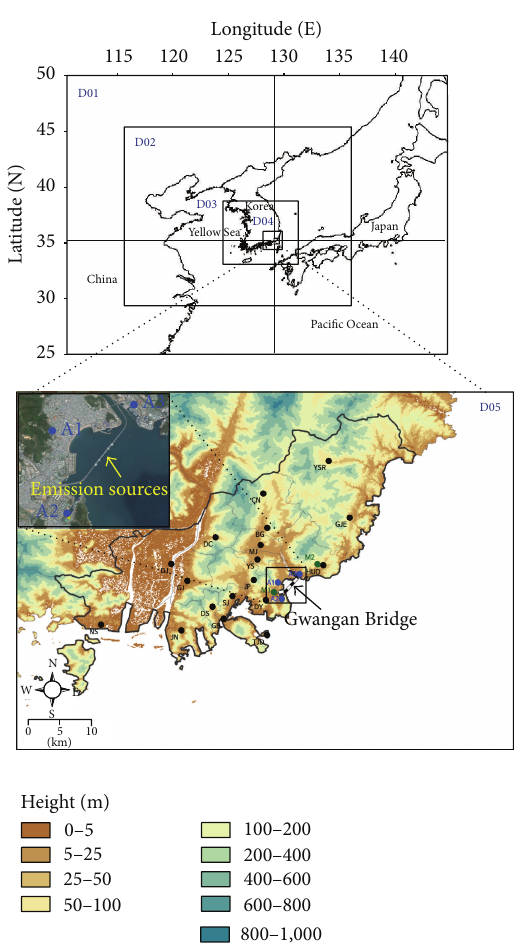
Figure 1: Location map of sampling sites (A1–A3) of trace metals and elements during the firework event days of 2011–2013 and meteorological monitoring sites (M1 and M2). Solid black circles represent environmental monitoring sites, where the concentrations of criteria air pollutants (O 3 , PM 10 , NO 2 , CO, etc.) are routinely